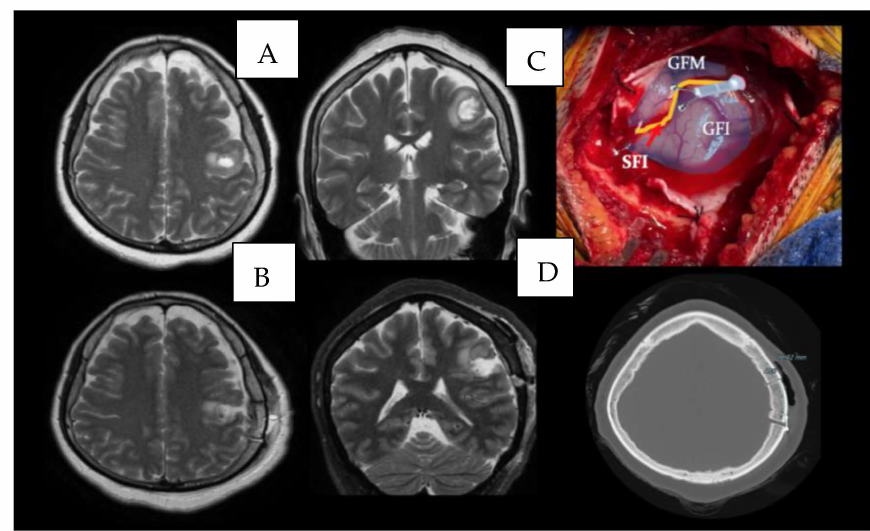
Figure 5. ( A ) Axial and coronal view of a preoperative T2 weighted MRI; ( B ) the postoperative axial and coronal view of a preoperative T2 weighted MRI that documents the GTR; ( C ) an intraoperative view of the cortical surface with the tracts highlighted; ( D ) the postoperative CT scan with bone algorithm that shows the small